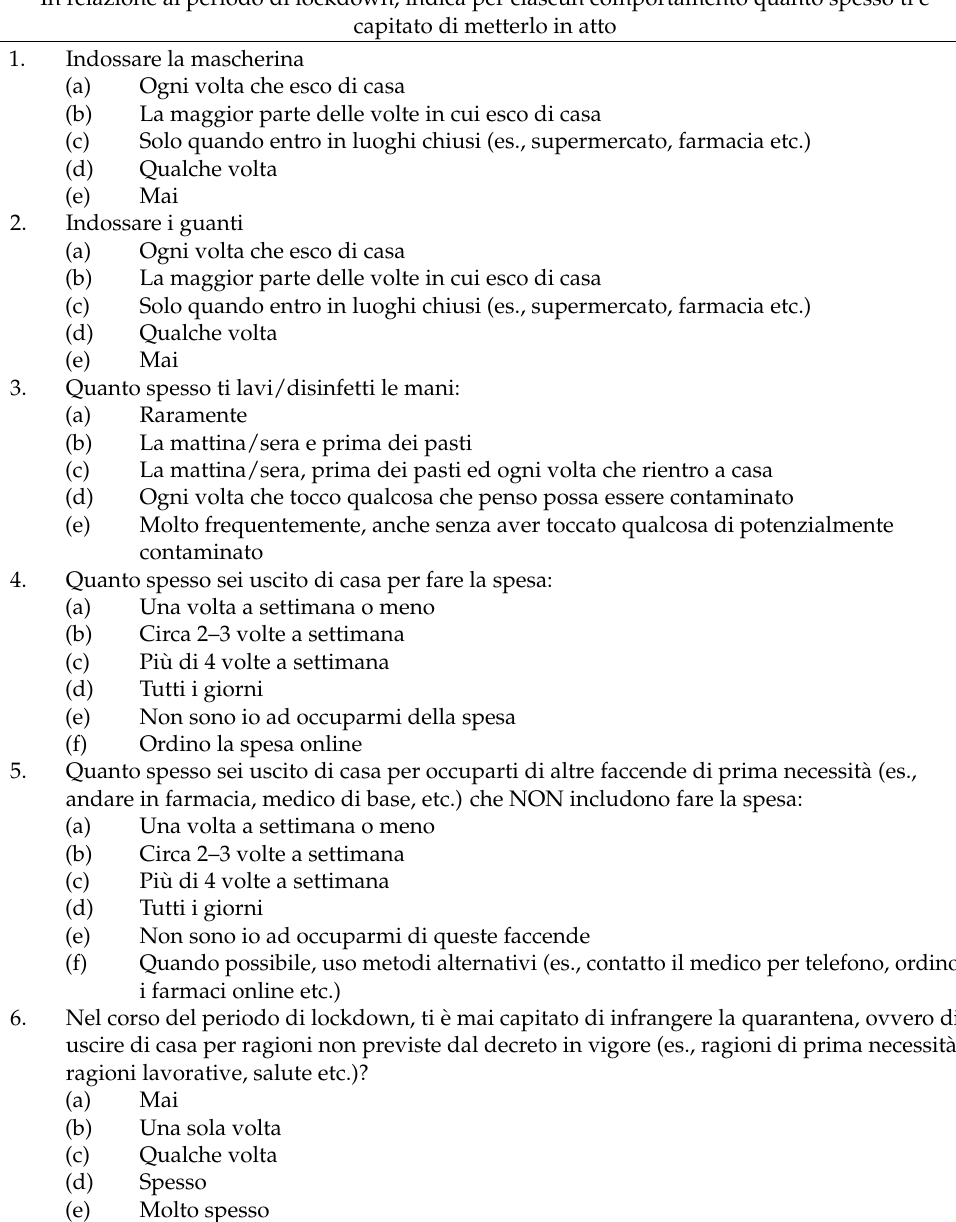
(Contagion Risk Index)